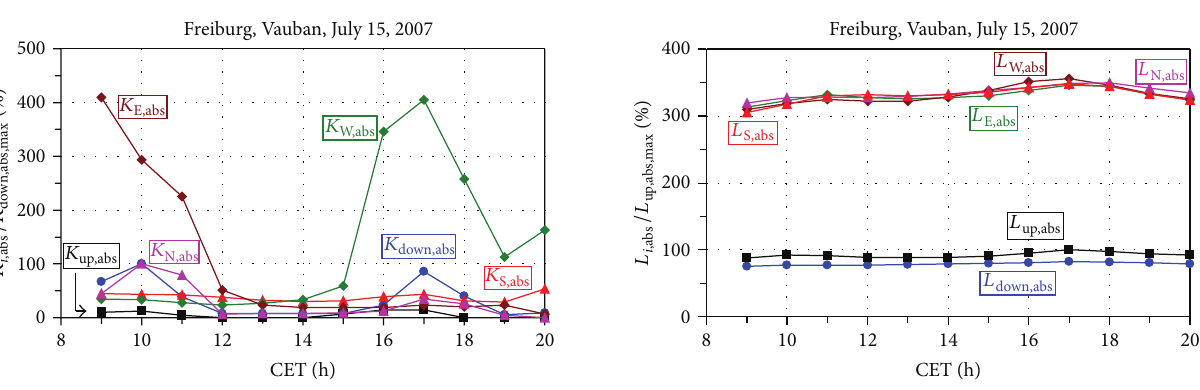
Figure 10: 1h mean values of the long-wave radiant flux densities 𝑖 = down, up, E, S, W, and N) from the three-dimensional 𝐿 𝑖, abs ( environment absorbed by the human-biometeorological reference ( 𝐾 = person, related to the 1h peak value of 𝐿 down , abs down , abs , max NNE-facing sidewalk of a WNW-ESE street canyon, “Vauban” quarter in Freiburg during typical Central European summer day.